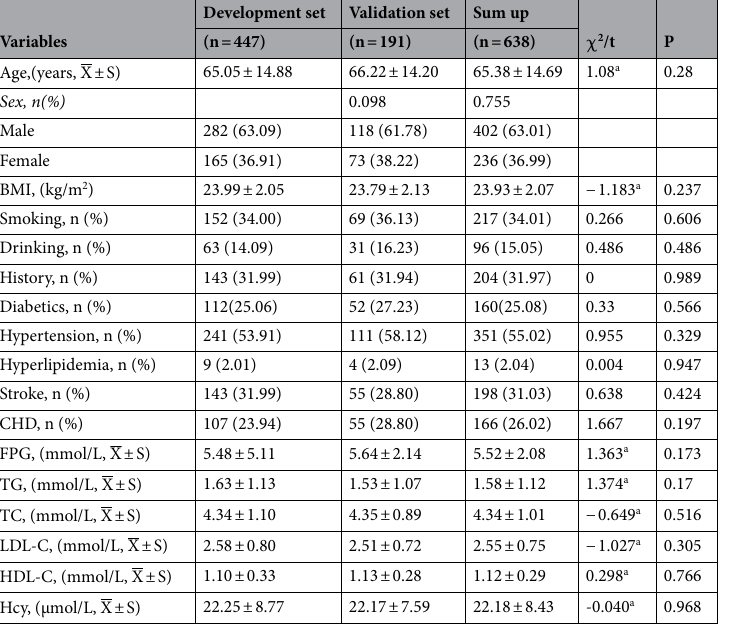
Table 1. Demographic characteristics of development set and validation set. BMI body mass index, CHD coronary heart disease, FPG fasting plasma glucose, TG triglycerides, TC total cholesterol, LDL-C low density